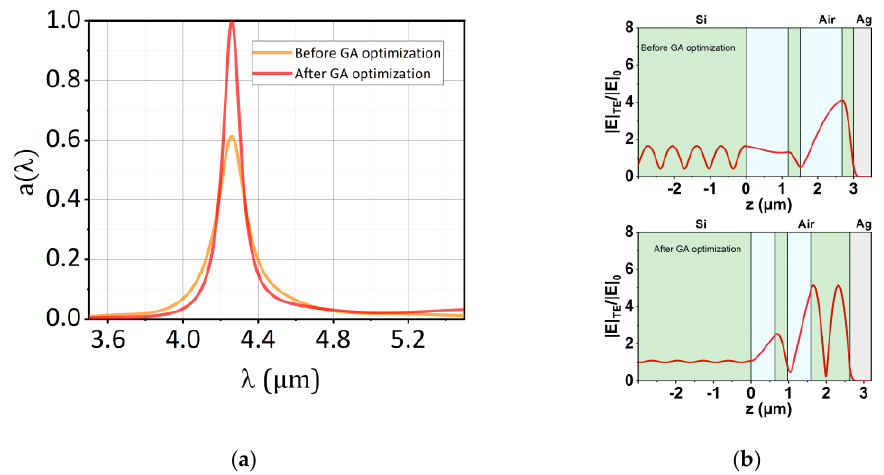
Figure 2. ( a ) Spectral response of the 1D TP structure (TE) before and after GA optimization at an inclination angle 𝜃 𝛽 = 25° corresponding to a slab mode for a slab featuring 𝑤 = 1 µm; ( b ) Normalized electric field before and after GA optimization ( b ) Normalized electric field before and after GA